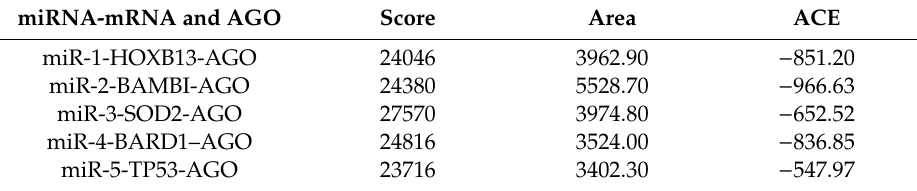
Table 9. Docking scores between miRNA-mRNA and AGO